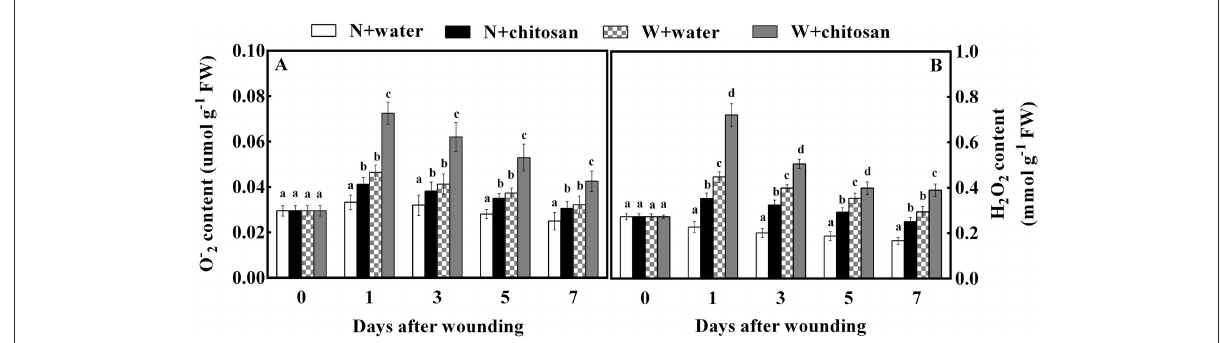
FIGURE1 Effect of chitosan treatment on O − 2 (A) and H 2 O 2 (B) content at apple wounds. Non-wounded fruit treated with sterile water (N + water), non-wounded fruit treated with chitosan (N + chitosan), wounded fruit treated with sterile water (W + water), and wounded fruit treated with chitosan (W + chitosan). Vertical bars indicate standard error of means. For each day after wounding, alphabets indicate significant differences ( P <